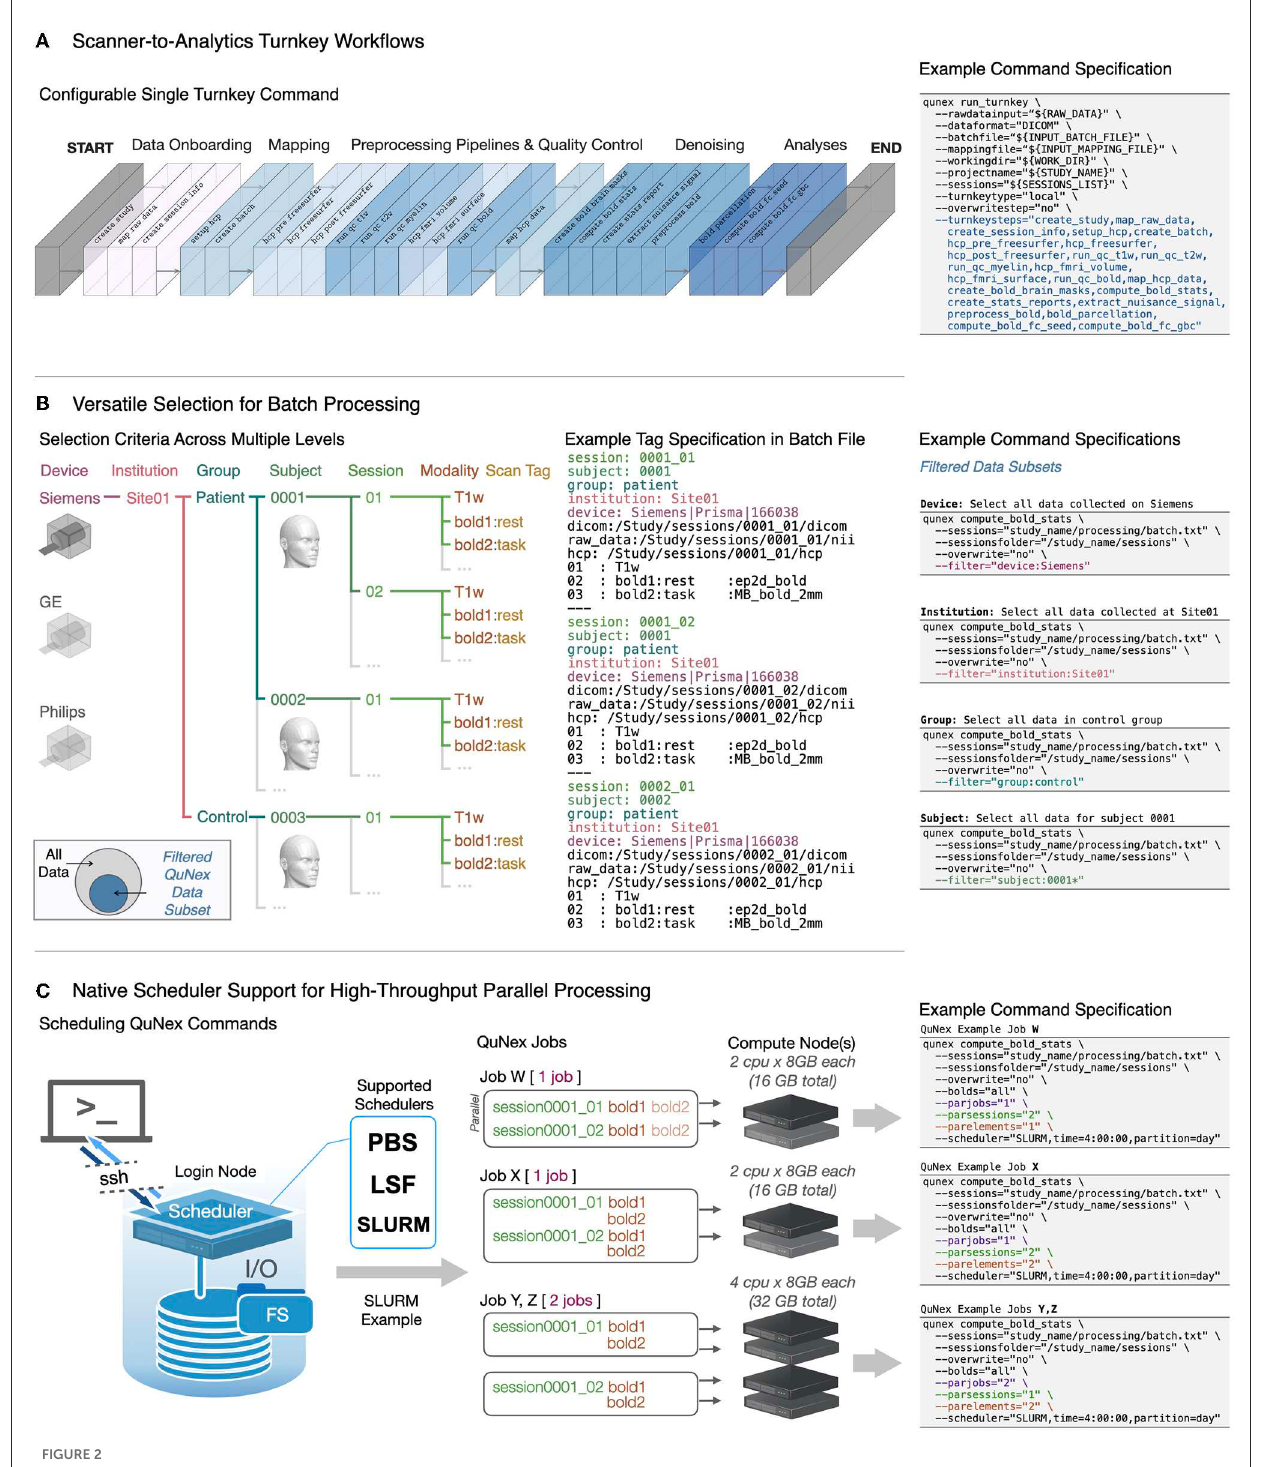
FIGURE2 QuNex turnkey functionality and batch engine for high-throughput processing. (A) QuNex provides a “turnkey” engine which enables fully automated deployment of entire pipelines on neuroimaging data via a single command ( qunex run_turnkey ). An example of a typical workflow with key steps supported by the turnkey engine is highlighted, along with the example command specification. QuNex supports state-of-the-art preprocessing tools from the neuroimaging community (e.g., the HCP MPP; Glasser et al., 2013). For a detailed visual schematic of QuNex steps and commands (see Supplementary Figure 1). (B) The QuNex batch specification is designed to enable flexible and comprehensive “filtering” and selection of specific data subsets to process. The filtering criteria can be specified at multiple levels, such as devices (e.g., Siemens, GE, or Philips MRI scanners), institutions (e.g., scanning sites), groups (e.g., patient vs. controls), subjects, sessions (e.g., time points in a longitudinal study), modalities (e.g., T1w, T2w, BOLD, diffusion), or scan tags (e.g., name of scan). (C) QuNex natively supports job scheduling via LSF, SLURM, or PBS schedulers and can be easily deployed in HPC systems to handle high-throughput, parallel processing of large neuroimaging datasets. The scheduling options enable precise specification of paralellization both across sessions and within session (e.g., parallel processing of BOLD images) for optimal performance and utilization of cluster